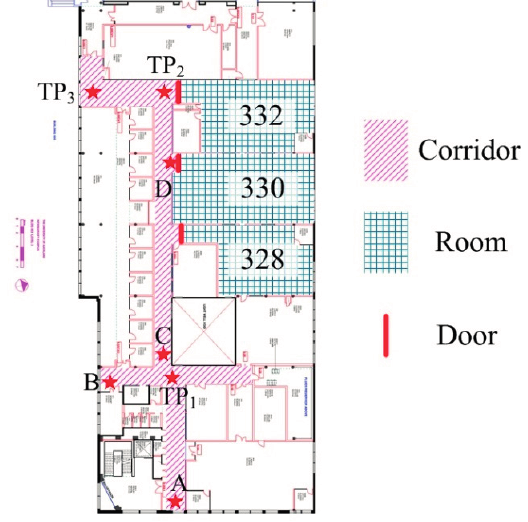
Figure 6. Illustration of different